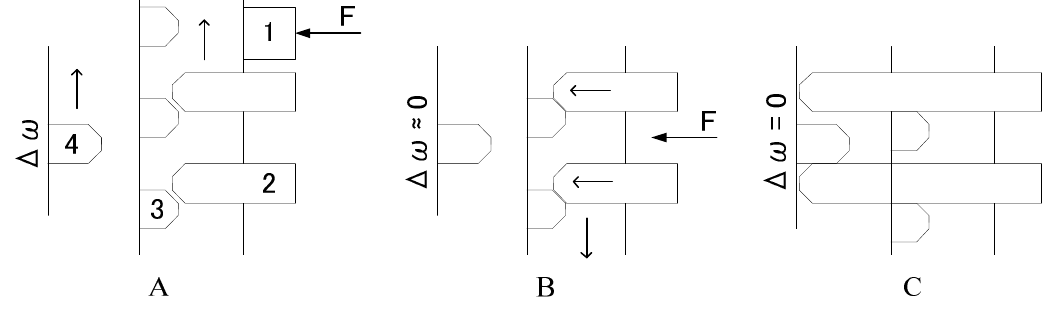
Figure 2. Synchronization process of the synchronizer. ( A ) Step 1, ( B ) Step 2, ( C )Step 3.